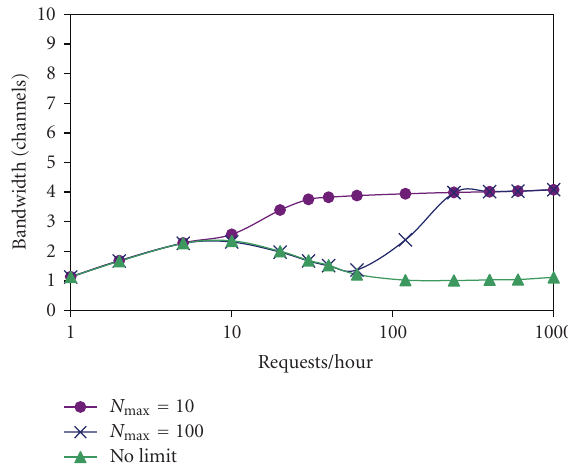
Figure 5: Network bandwidth requirements of the new stream tapping protocol.